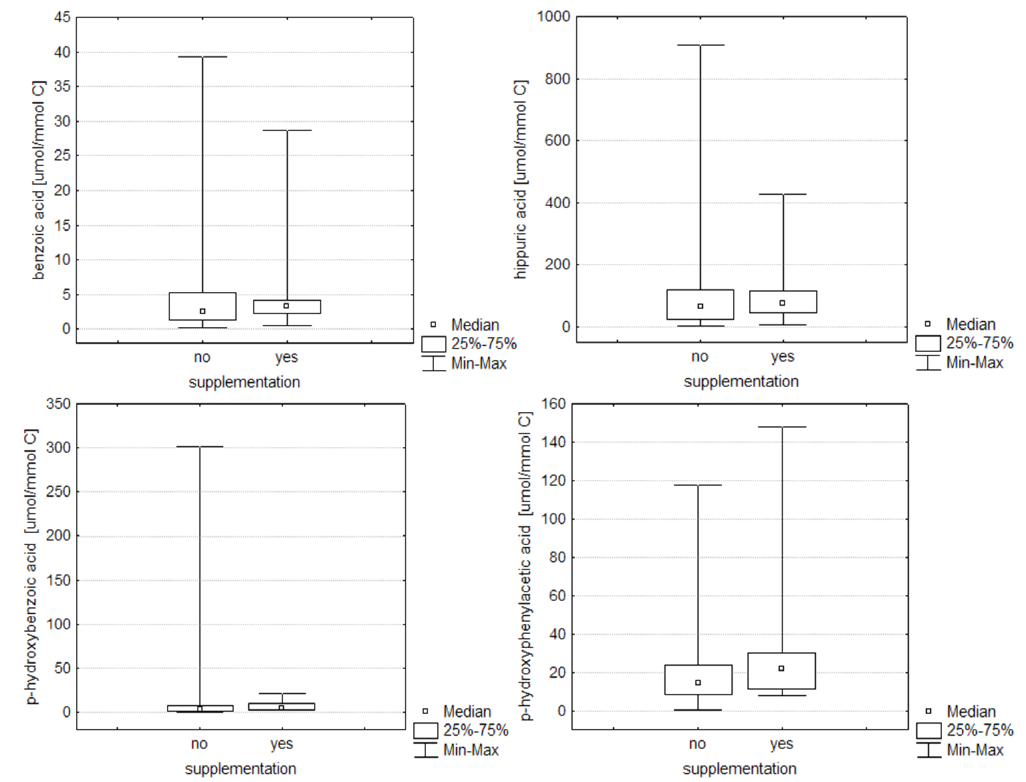
Figure 3 Box and Whisker plots for the determined acid level in the groups with and without probiotic supplementation. In these box plots, medians inside the 25–75% interquartile range (IQR) are presented